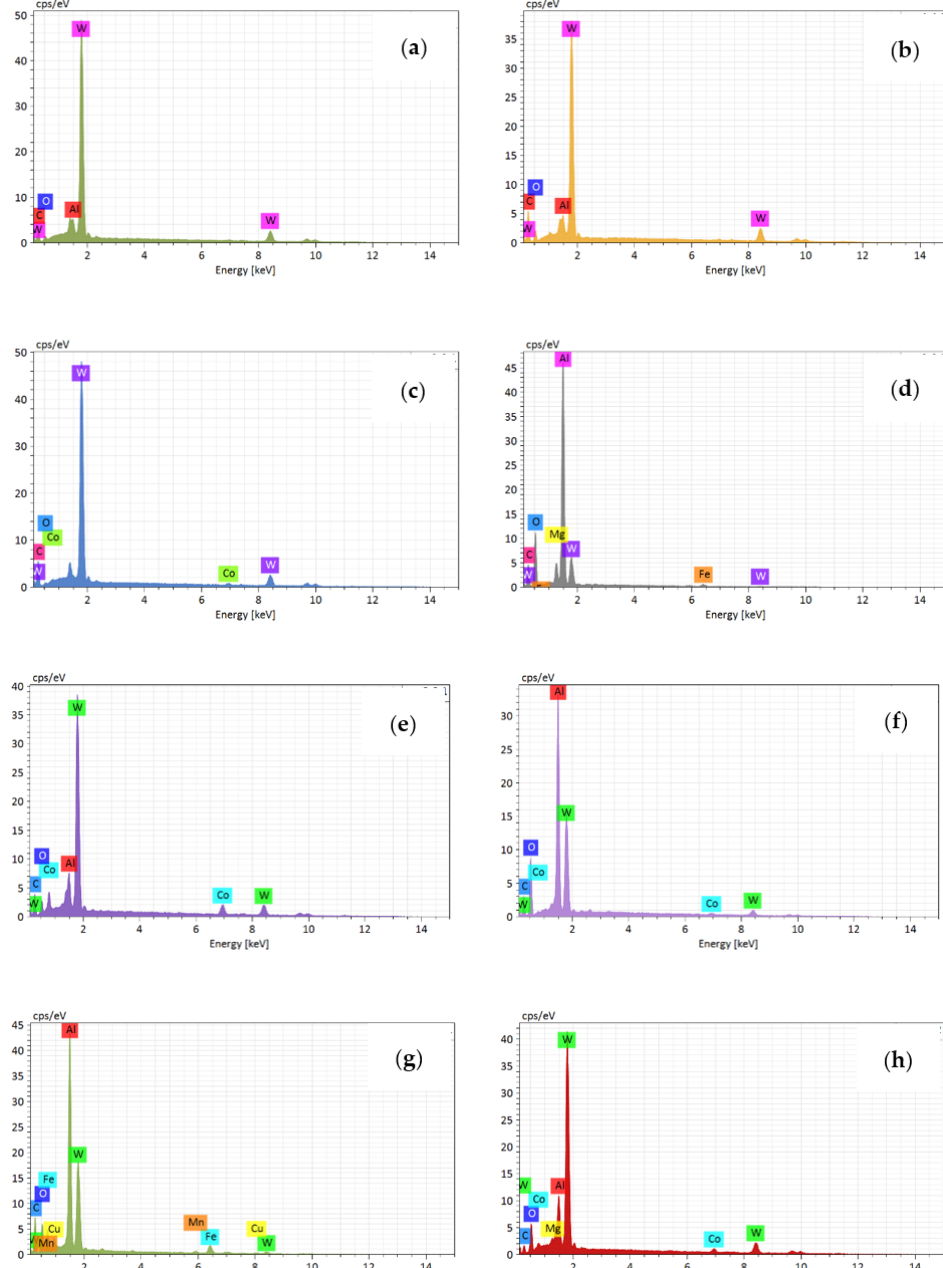
Figure 9. The EDS results of flank face wear morphology at different cutting speed (( a – h ) represent the points A~H in the Figure 8 respectively).